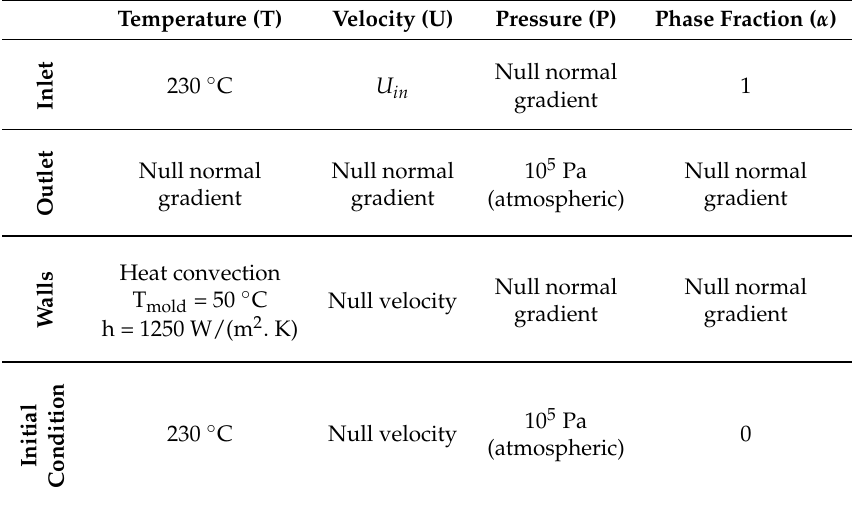
Table 1. Initial and boundary conditions for all case studies.